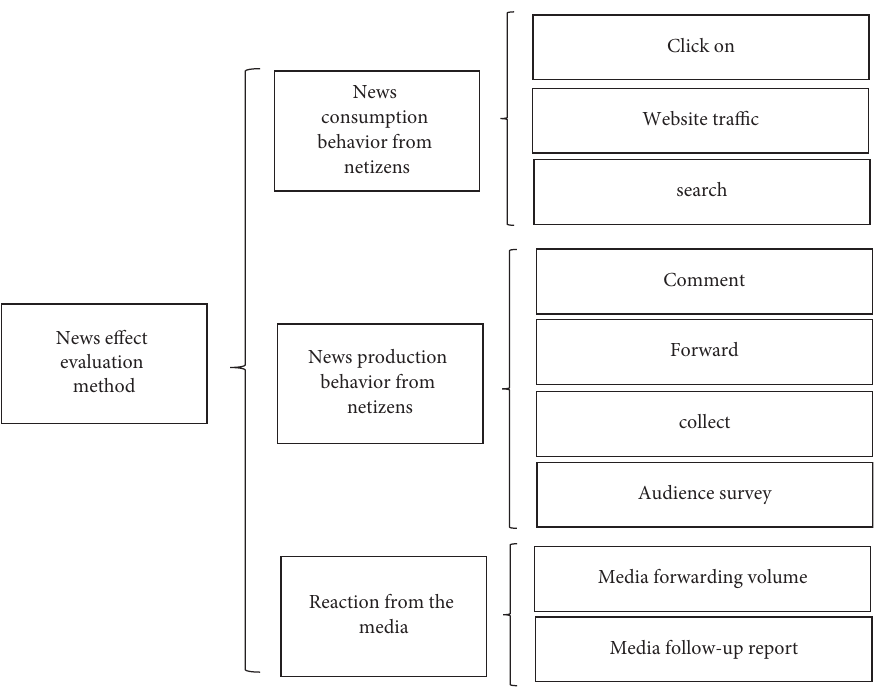
Figure 5: Evaluation method of news dissemination effect.